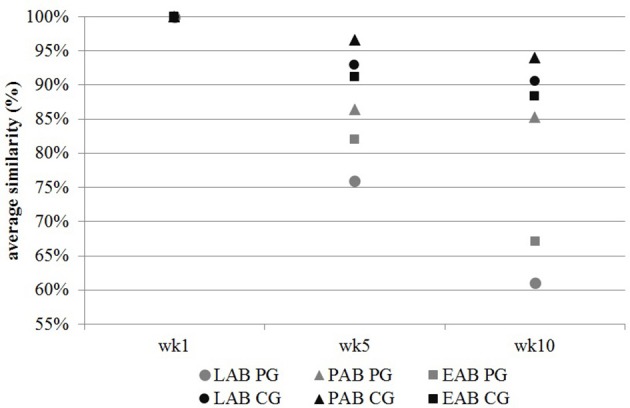
Change in bacterial communities of the liquid- (LAB), particle- (PAB), and epithelium-associated bacteria (EAB) over time expressed in average similarity (in %) of samples compared to their reference sample in wk 1. CG, confinement group, PG, pasture group (n = 5). A significant greater decrease in similarity over time in all three bacteria populations was observed for the PG compared to the CG (PEAB = 0.002, PLAB = 0.008; PPAB = 0.003; SDEAB = 11%; SDLAB = 8%, SDPAB = 16%). The CG stayed on a TMR based ration during the entire trial while the PG was slowly introduced to a pasture-based ration: wk 1: TMR, wk 2: TMR and 3 h pasture/d, wk 3 and 4: TMR and 12 h pasture/d, wk 5–10: pasture and 1.75 kg DM concentrate/d.